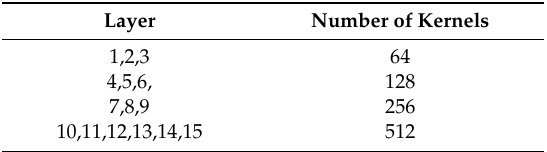
Table 3. Number of samples used in the experiment. Table 1. Number of convolution kernels for each convolutional layer.